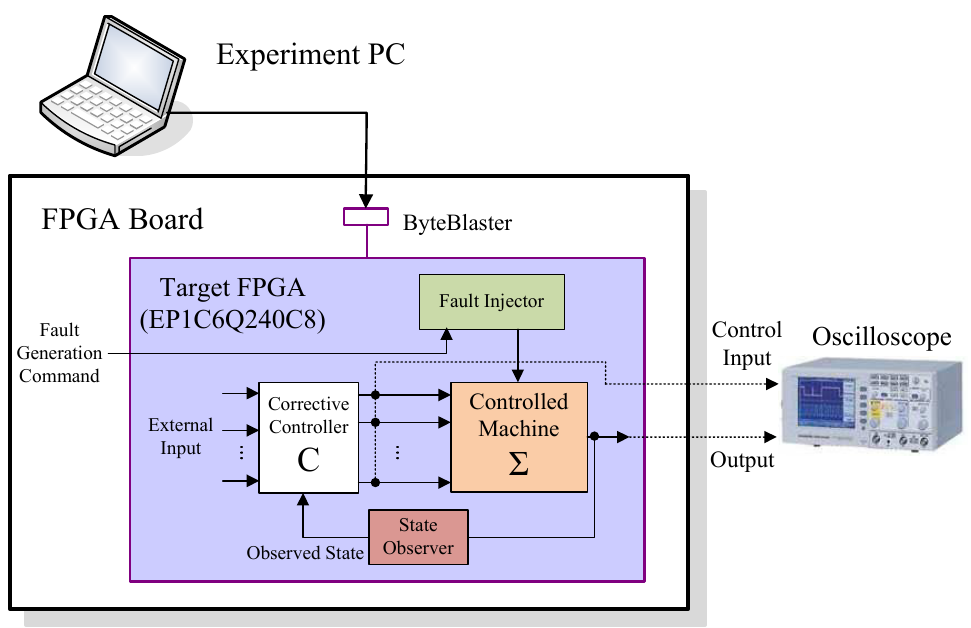
Figure 7. The architecture of the experimental setup